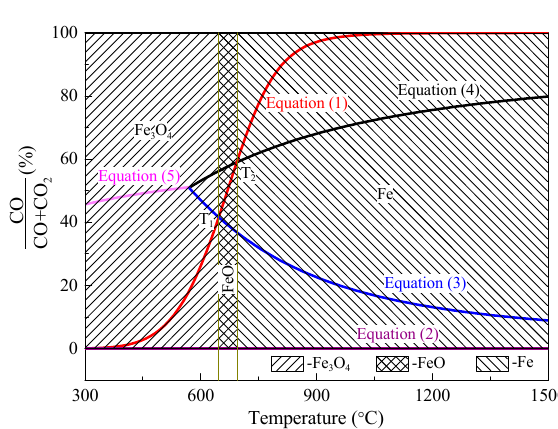
Figure 4. Gas ‐ phase equilibrium of iron oxides reduced by solid carbon. Figure 4. Gas-phase equilibrium of iron oxides reduced by solid